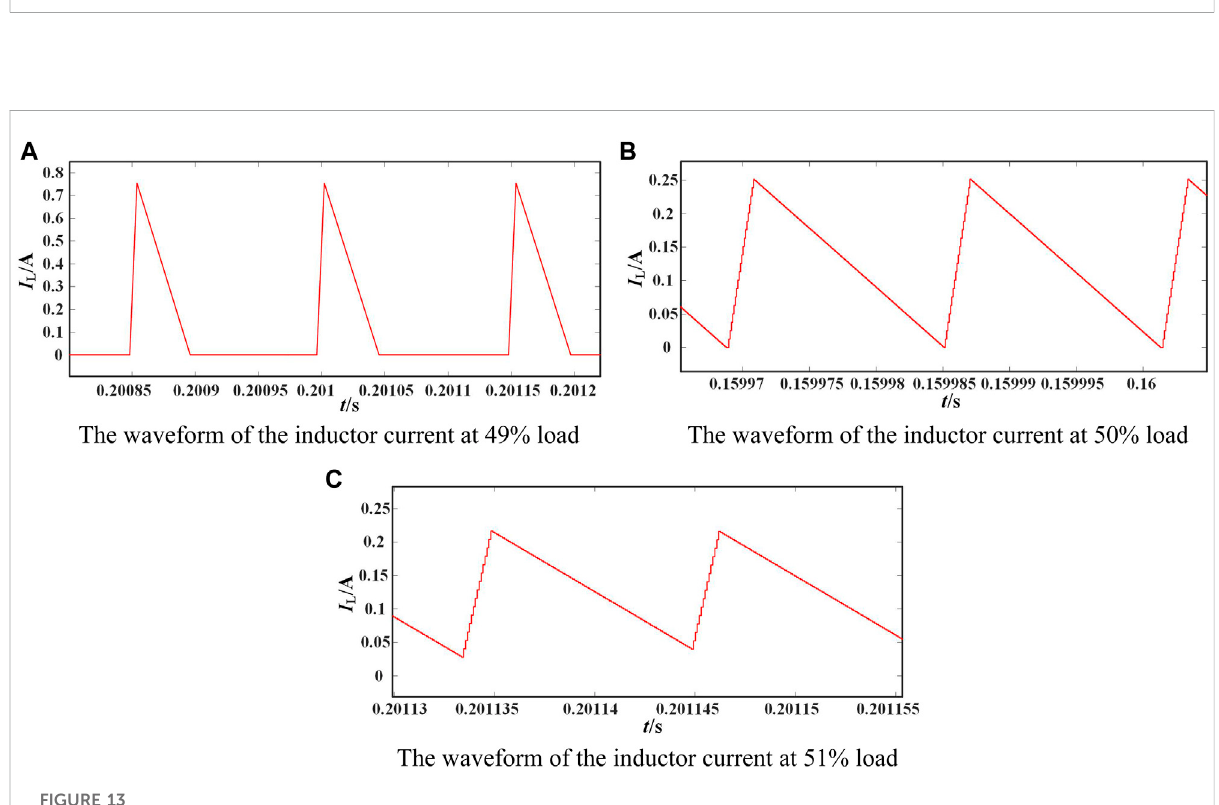
Inductor current waveforms with the mode switching at 3W rated